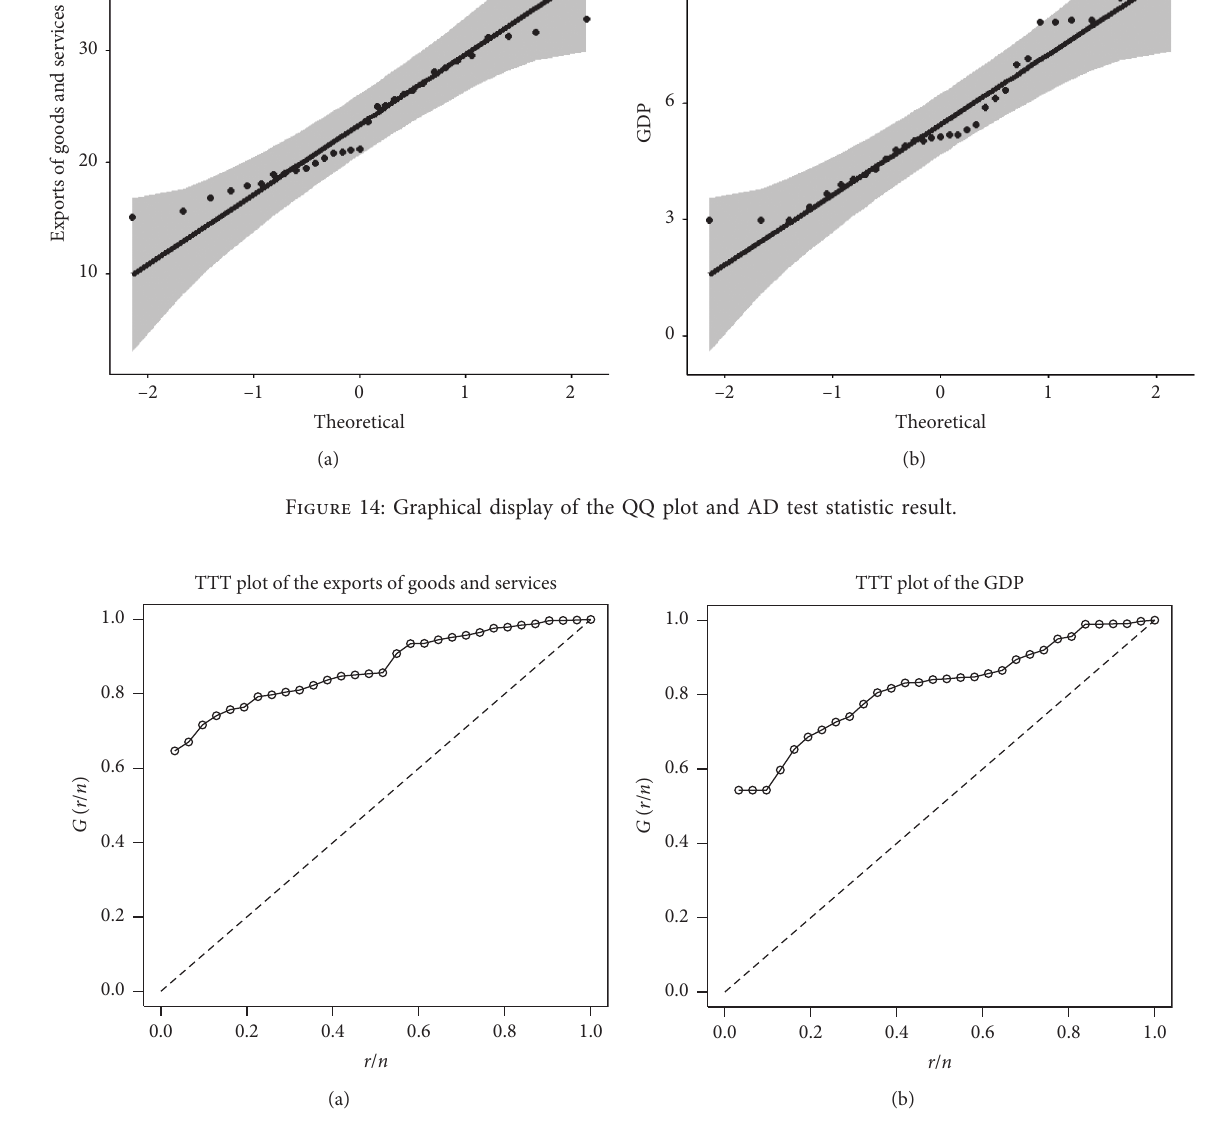
Figure 15: The TTT plot of the economics data.